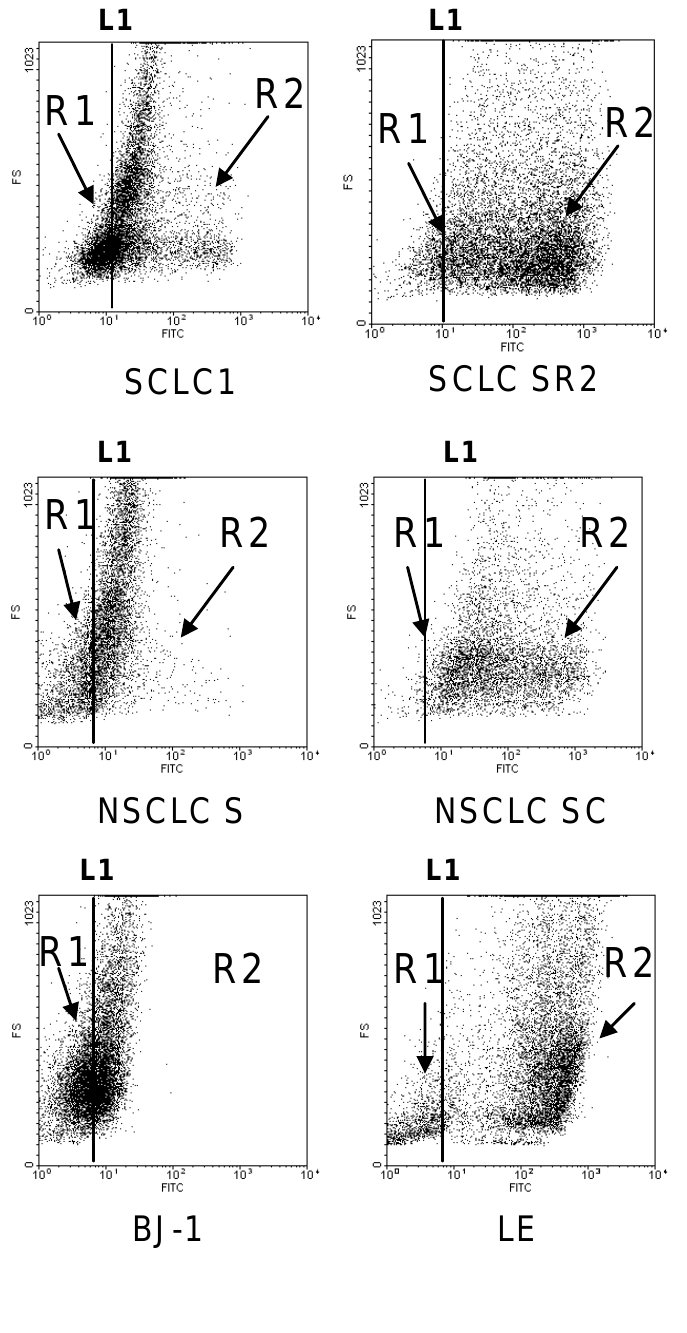
Figure 2. Flow cytometry analysis of H probe indicated that there are 2 populations of cells: R1 (low H (high H O production). Resistant cells SCLCSR2, NSCLCSC, and LE have more R2 2 2 population than cisplatin sensitive cells and BJ-1. Each dot plot is representative of three experiments. All cisplatin resistant cell lines have more R2 than R1 population with an average P < 0.005. Line L1 is arbitrarily set as the average H cells